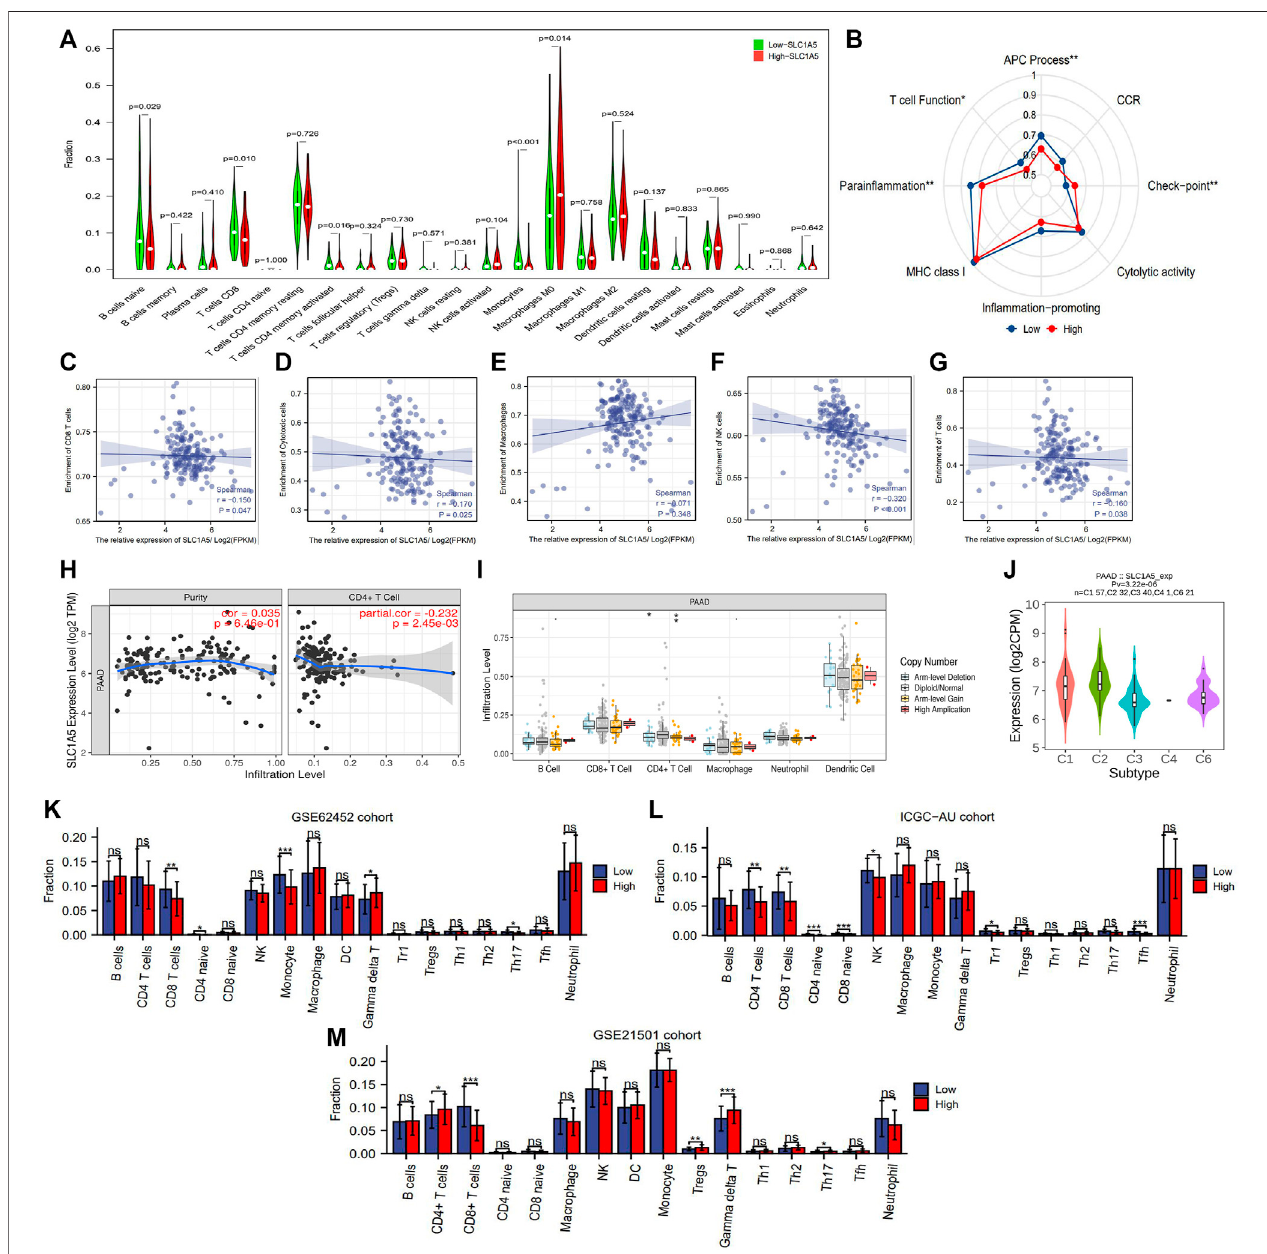
FIGURE 5 | The effects of SLC1A5 on TIM. (A) The differences in the in fi ltrating levels of 22 immune cells between the high- and low-SLC1A5-expression groups (TCGAcohort). (B) Thedifferencesintheactivitiesof8immune-relatedpathwaysbetweenthedifferentSLC1A5expressiongroups. (C – G) Thecorrelationsbetweenthe SLC1A5expression and the enrichment of fi ve core immune cells. (H) Thecorrelations between the SLC1A5 expression and the in fi ltratinglevels ofCD4 + Tcells. (I) The relationshipbetweenSLC1A5SCNAandthein fi ltratinglevelsofsixcrucialimmunecells. (J) TheexpressivedistributionsofSLC1A5in fi vePAADimmunesubtypes. (K – M) The SLC1A5 expression affects the in fi ltrating levels of multiple immune cells in three external cohorts (GSE62452, ICGC-AU, and GSE21501). TIM, tumor immunemicroenvironment; PAAD,pancreatic adenocarcinoma; ICs,immunecheckpoints;CD274isalsoknownasPD-1;NS,nostatisticaldifferences;* p < 0.05,** p < 0.01, and *** p <